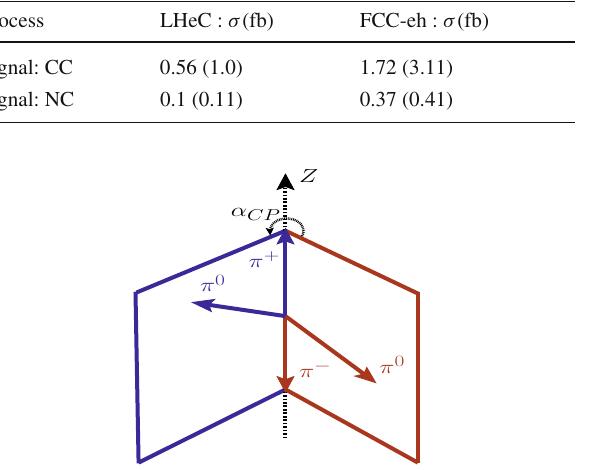
Fig. 2 Representative diagram for the decay planes spanned by the charged and neutral pion produced from respective τ ± -lepton in the π + π − rest frame. The angle between the two decay planes is denoted as α CP which is utilised here to explore the CP admixture of the h τ ¯ τ coupling